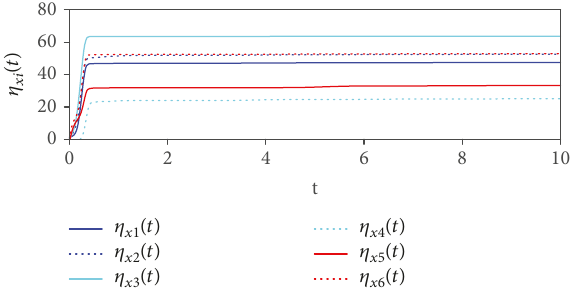
Figure 5: The convergence of the control gains η controllers (15): lim